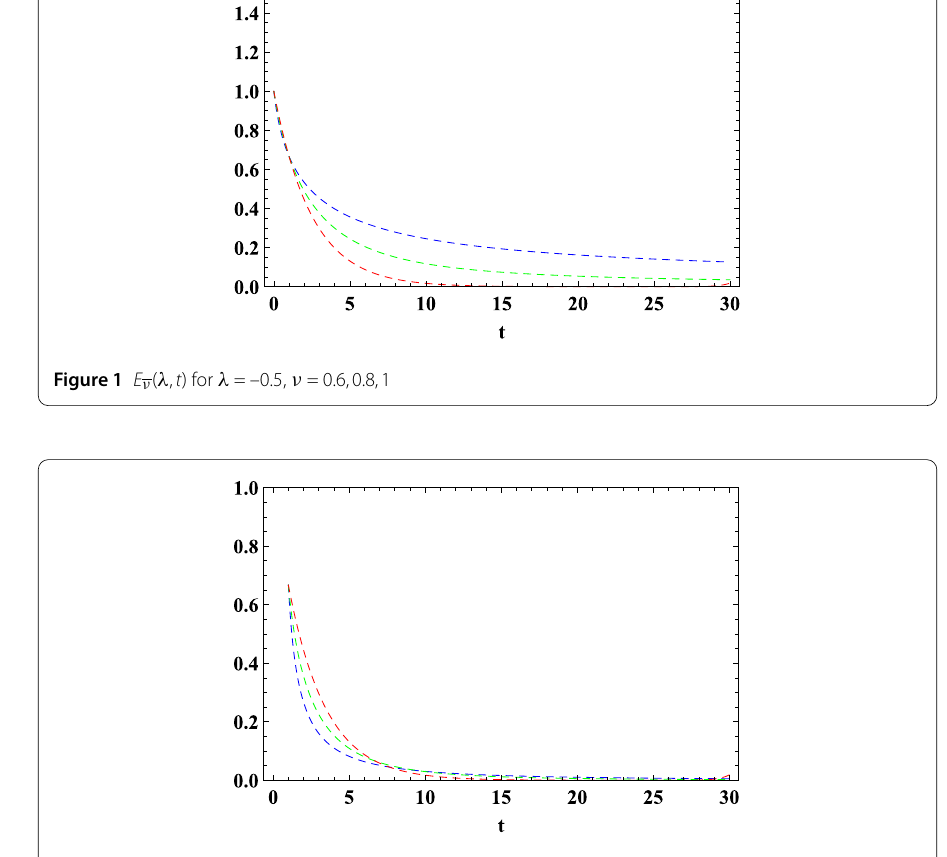
Figure 2 E ν , ν ( λ , t ) for λ = –0.5, ν =